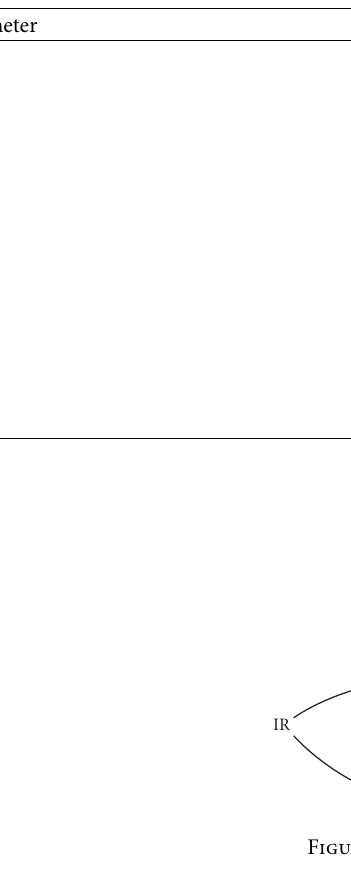
Table 1: Definition of parameters in Figure 1.